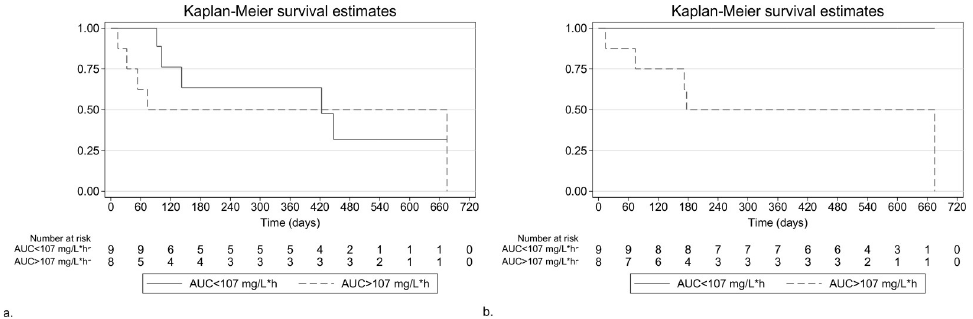
Fig 4. Time to linezolid-related adverse events by linezolid exposures in children treated for MDR-TB. (a) Kaplan- Meier survival curves for time to first linezolid-related adverse event of any grade by linezolid-related AUC 0–24ss < 107 mg/L � h versus AUC 0–24ss < 107 mg/L � h (log-rank p = 0.5895); over a 450-day follow-up, the RMST was not significantly different by AUC 0–24ss (295 days if AUC 0–24ss < 107 mg/L � h; 222 if AUC 0–24ss > 107 mg/L � h [ p = 0.344]). (b) Kaplan- Meier survival curves for time to grade 3 or 4 linezolid-related adverse event by linezolid-related AUC 0–24ss < versus > 107 mg/L � h; log-rank p = 0.0121. AUC 0–24ss = steady state area under the concentration time curve from 0–24 hours; MDR-TB, multidrug-resistant tuberculosis; RMST, restricted mean survival